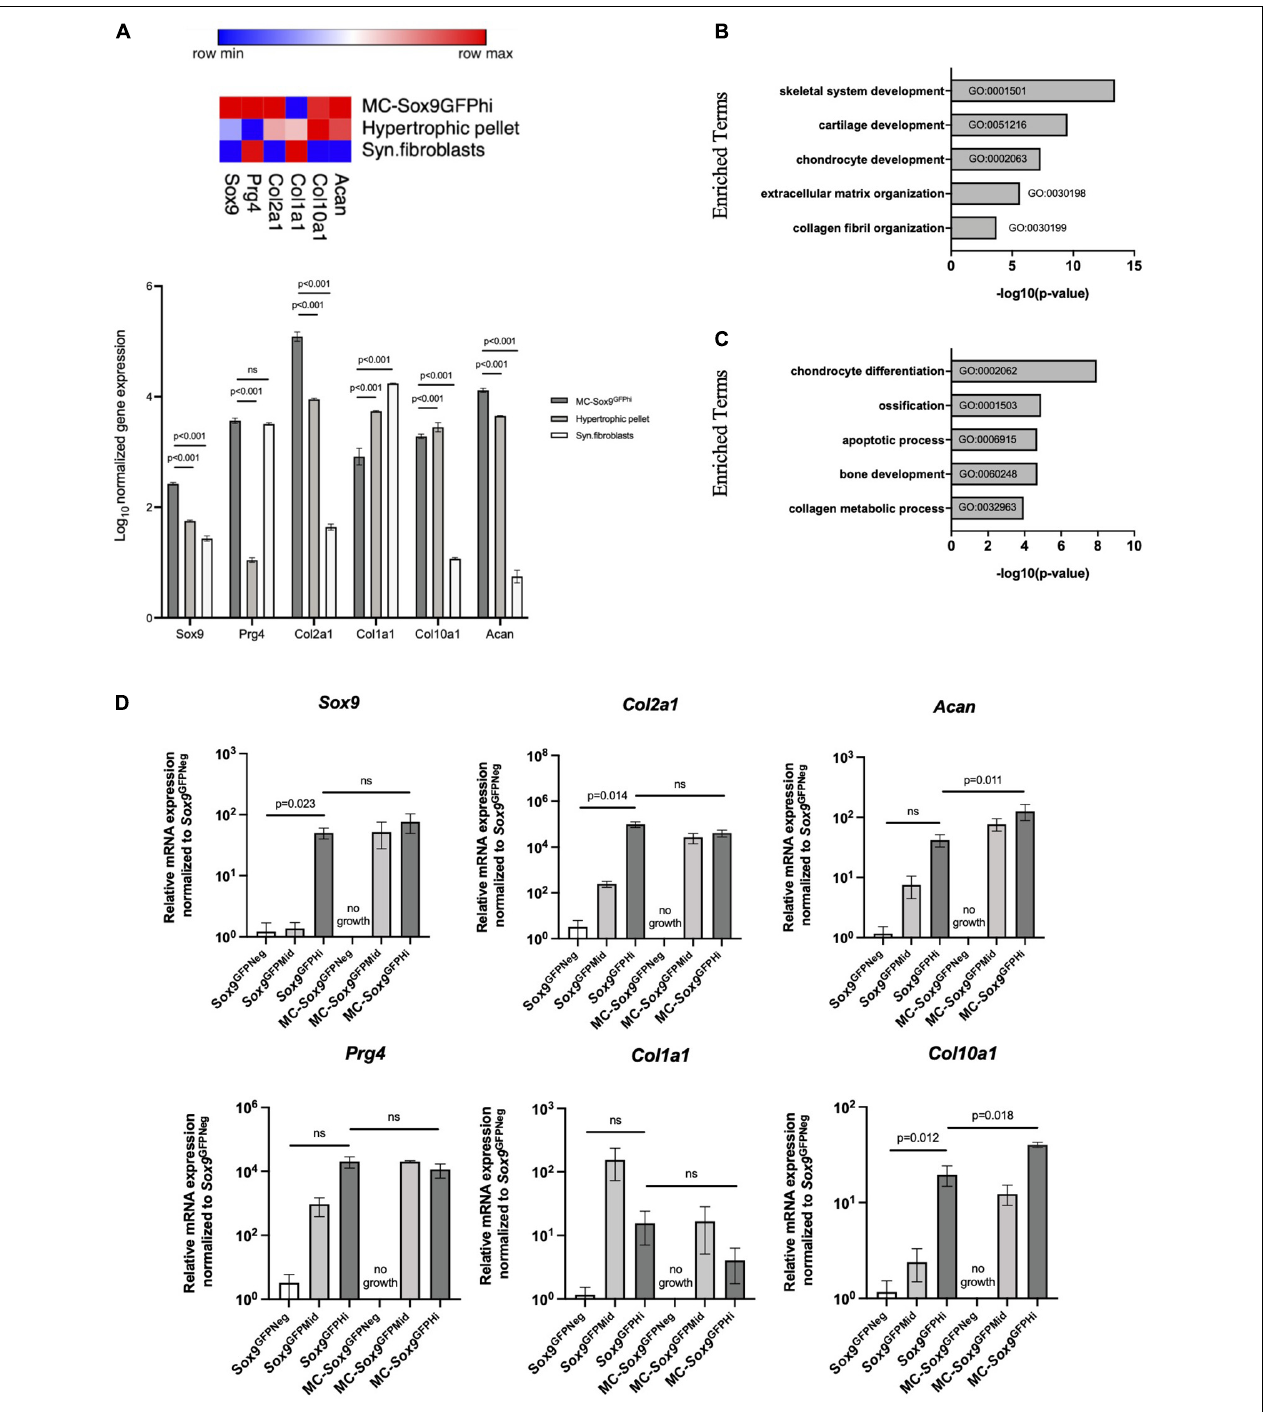
FIGURE 3 | Sox9 GFP chondrocytes cultured in 3D culture maintain chondrogenic gene expression. (A) Heatmap and quantification showing the normalized bulk-sequencing gene expression profile for selected chondrogenic genes in Sox9 GFPHi chondrospheres, hypertrophic pellet, and synovial fibroblasts (Saeki and Imai, 2020 and Singh et al., 2021, respectively). Color scale denotes the minimum (blue) and maximum (red) expression value across each row. P -values were calculated with two-way ANOVA with Tukey’s correction for multiple comparisons. (B) Gene Ontology analysis showing enriched terms of Sox9 GFPHi chondrospheres versus synovial fibroblasts ( n = 2 and 3, respectively). (C) Gene Ontology analysis showing enriched terms of hypertrophic pellets versus Sox9 GFPHi chondrospheres ( n = 3 and 2, respectively). (D) Quantitative PCR analyses of chondrocyte-specific genes after normalizing expression to freshly isolated Sox9 GFPNeg chondrocytes; n = 4 biological replicates for freshly isolated Sox9 GFP fractions, n = 2 biological replicates for MC – Sox9 GFP fractions. P -values were calculated with one-way ANOVA with Tukey’s correction for multiple comparisons; all error bars represent mean ± SEM.